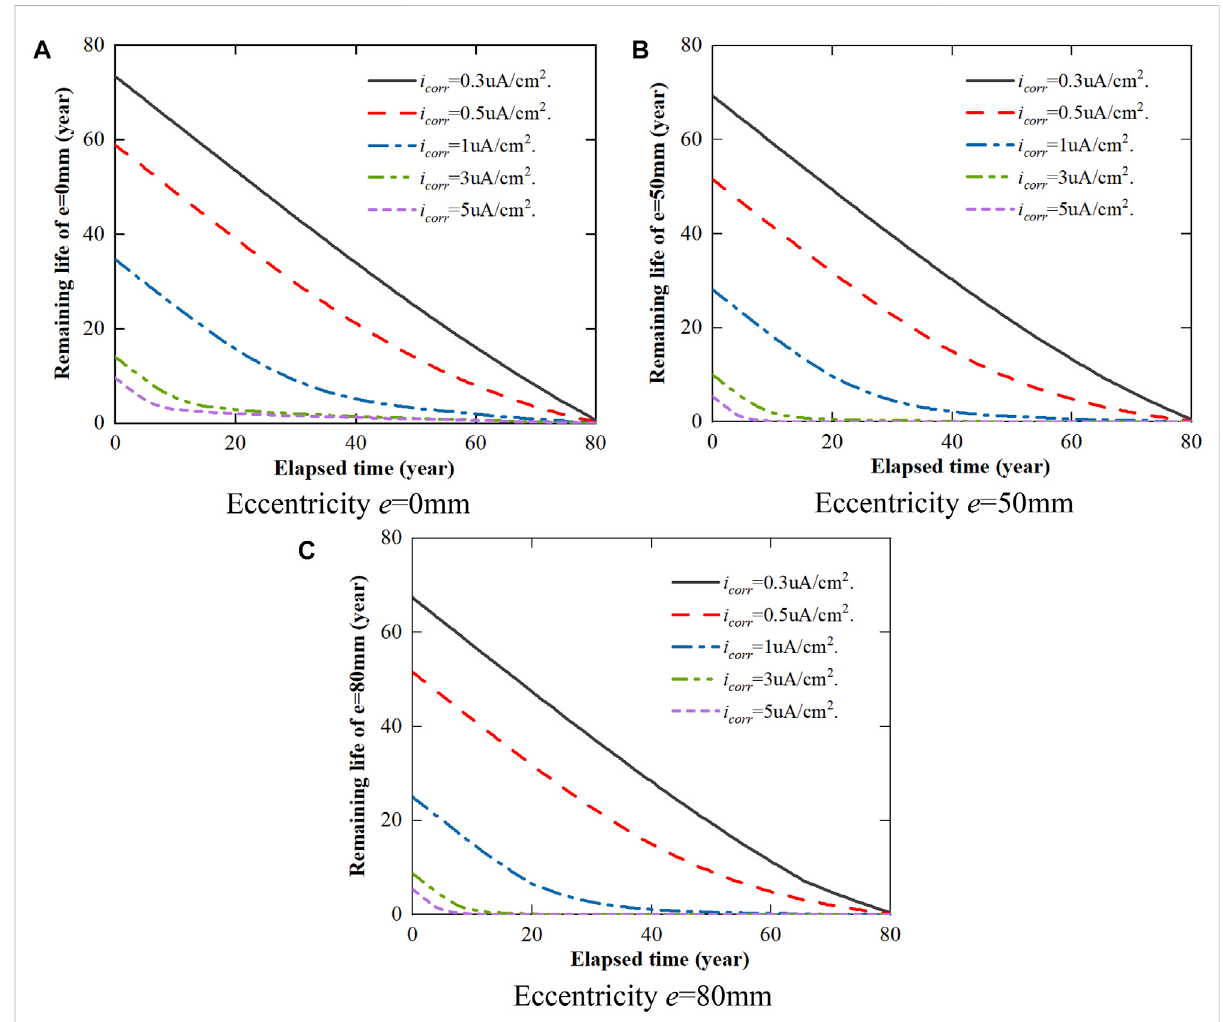
FIGURE 14 Estimated remaining useful life of the corroded column under different loading conditions for various corrosion